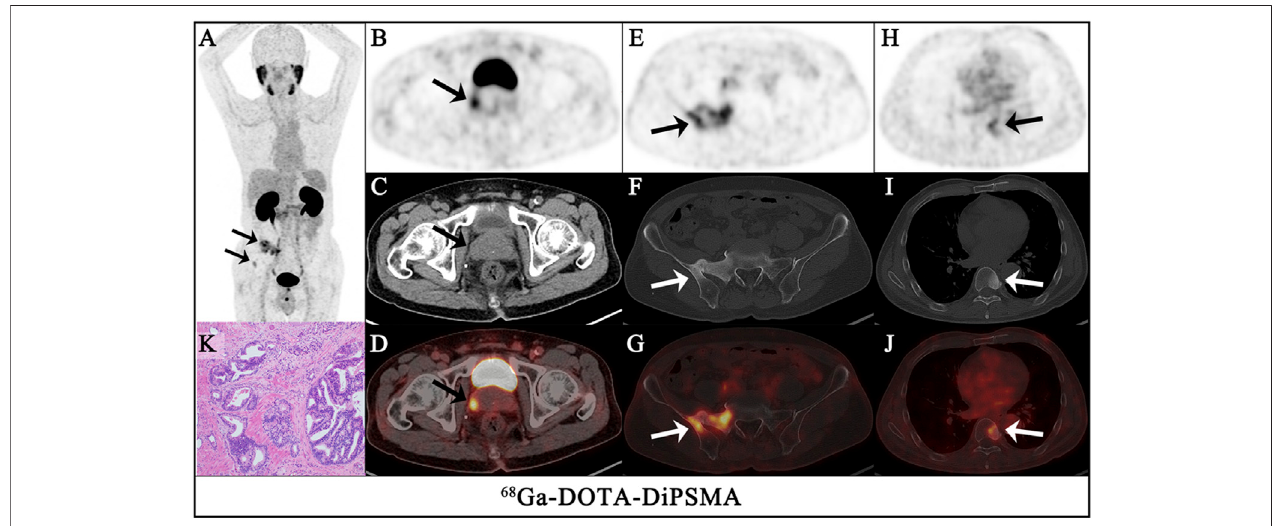
FIGURE 4 | A 68-year-old-man had con fi rmed prostate cancer after a needle biopsy of the prostate for 1 week. The maximum intensity projection (MIP) of 68 Ga- DOTA-DiPSMA PET/CT [ (A) , arrows] showed signi fi cantly abnormal uptake in the image. Axial views of the prostate (top, PET; middle, CT; bottom, fusion image) show intenseuptake(SUV max 3.3)intheisodensenoduleoftheprostate[ (B – D) ,arrows].Intheotherlevelaxialviews,increased 68 Ga-DOTA-DiPSMAuptakewasobservedin the sacrum and iliac [ (E – G) , arrows] and the 8th thoracic vertebrae lesions [ (H – J) , arrows], which were concomitant with bone density increased. Postoperative pathology con fi rmed it as adenocarcinoma of the prostate (K).